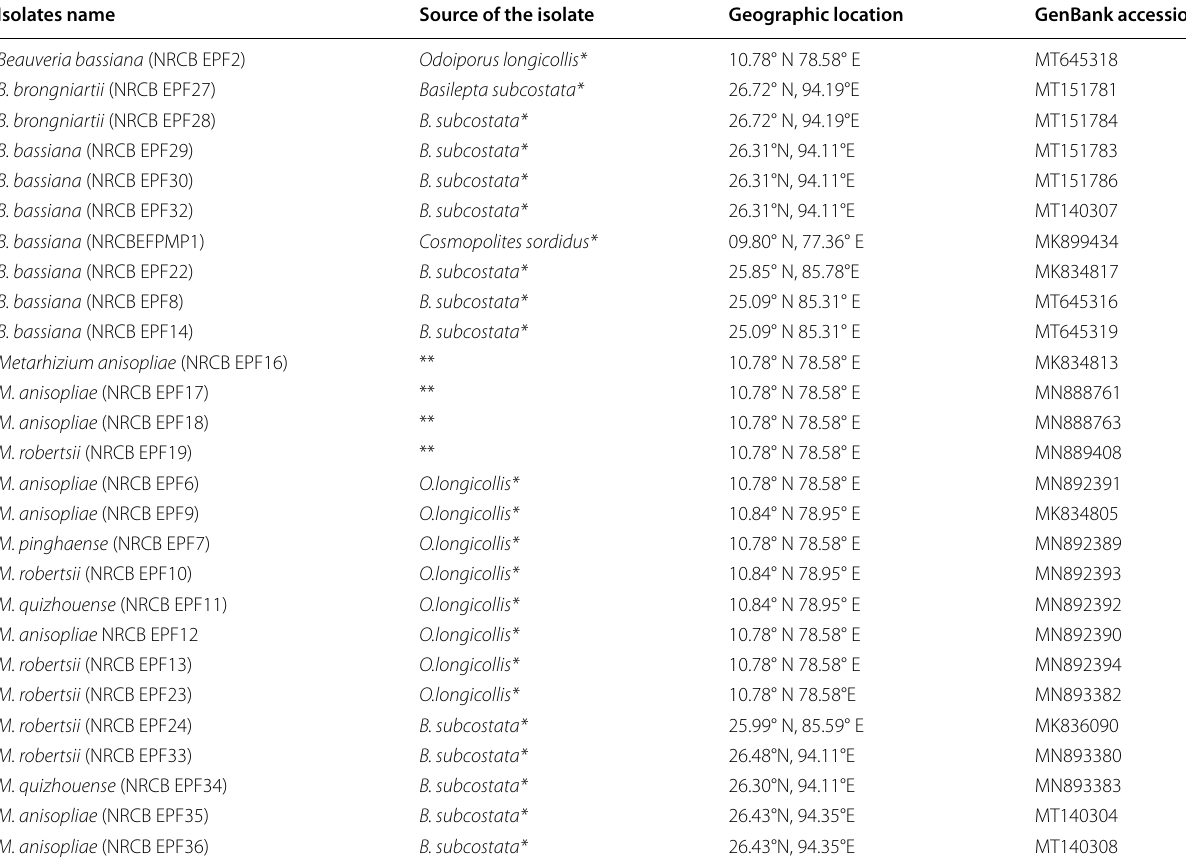
Table 1 Entomopathogenic fungi used in the study, their source and